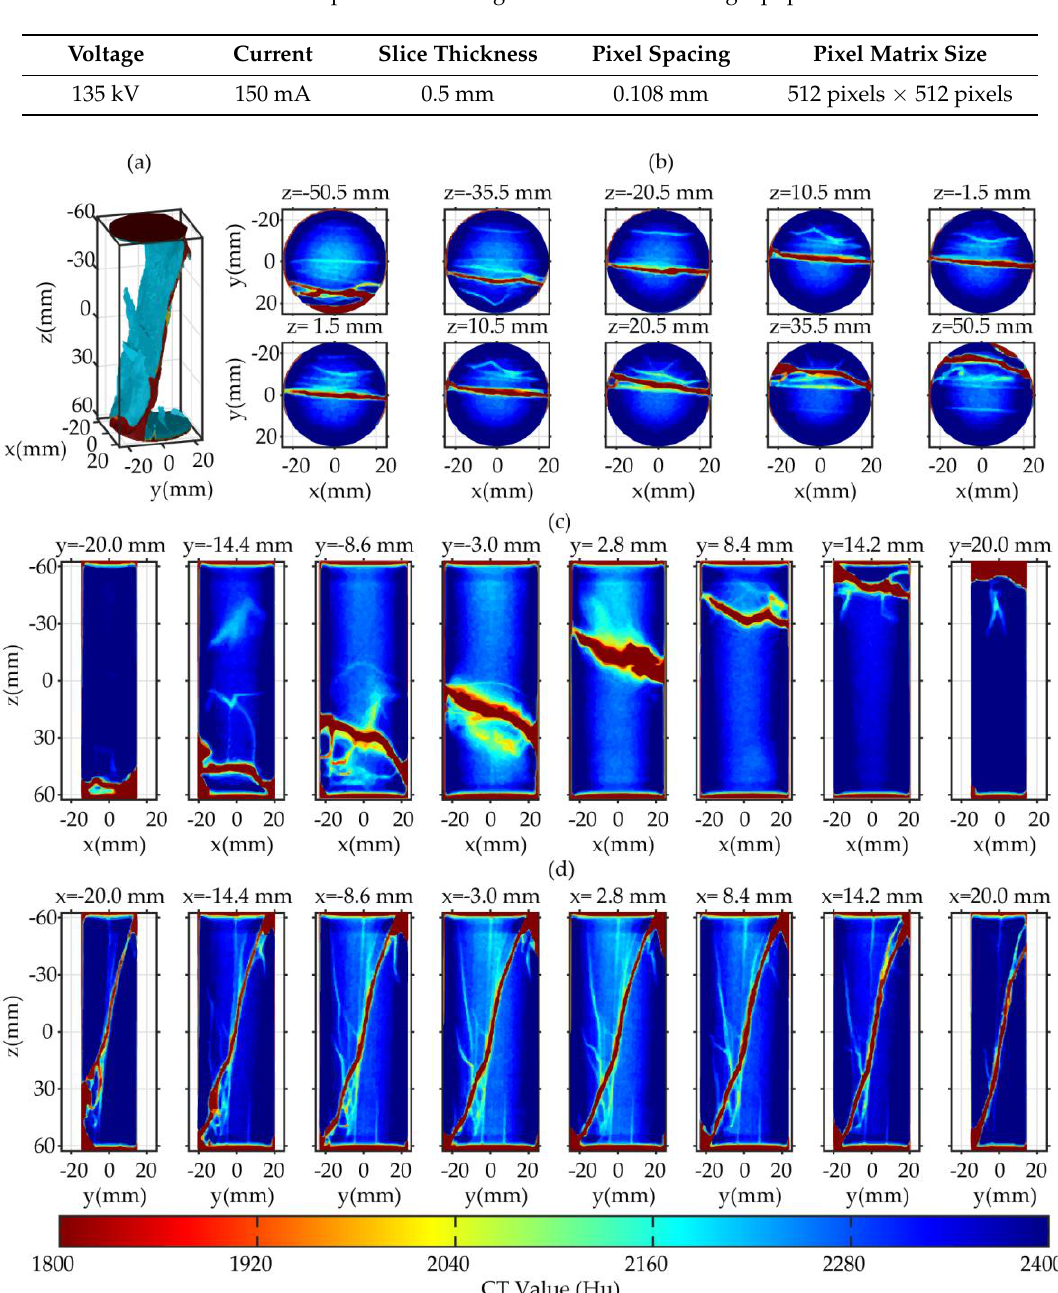
Table 1. The parameter settings for the X-CT scanning equipment.